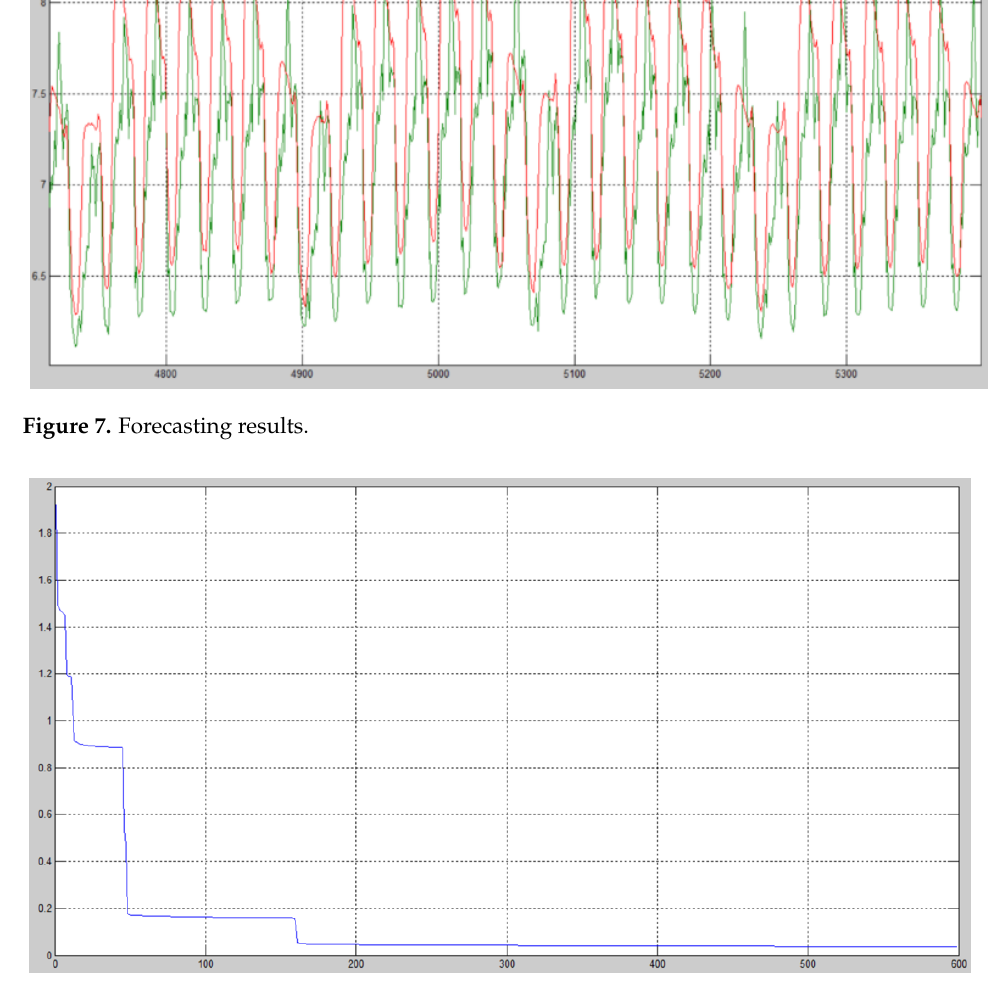
Figure 7. Forecasting results.